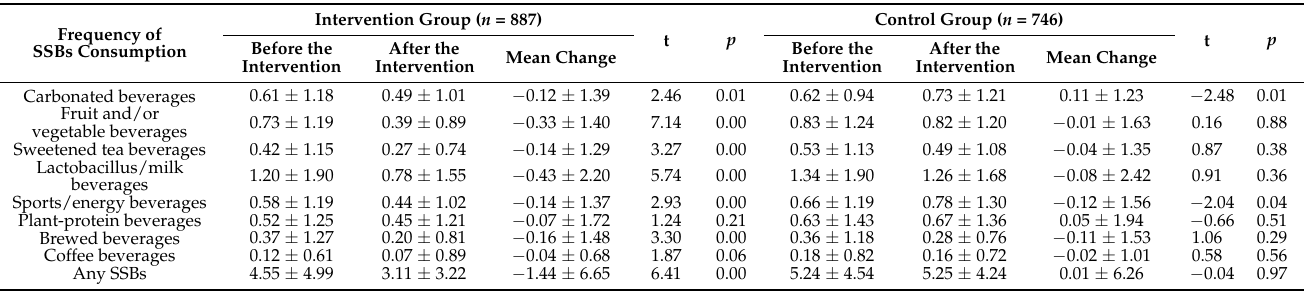
Table 6. Difference in sugar-sweetened beverages (SSBs) consumption frequency (times/week) before and after intervention (Mean ± SD).